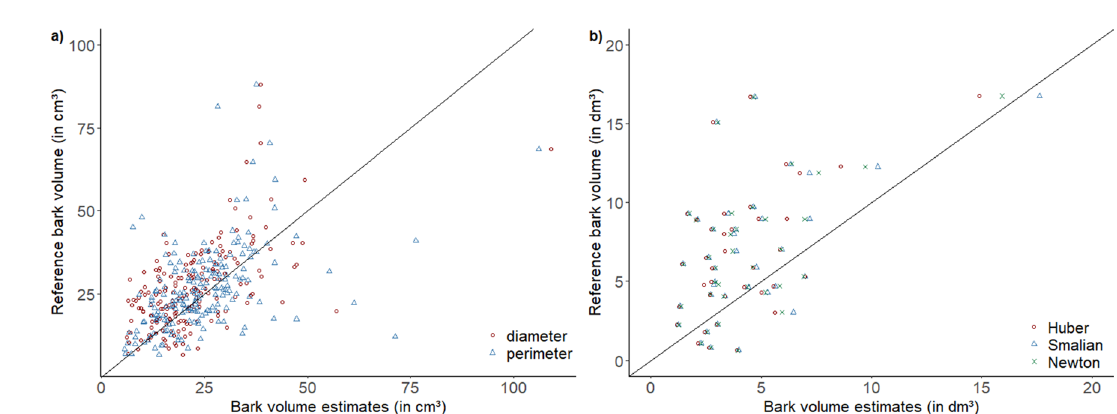
Figure 3. Scatterplots showing the reference bark volume (immersion) against bark volume estimations for ( a ) wood discs using the diameter (Eq. 2) and perimeter (Eq. 3) and for ( b ) logs using the scaling formulas Huber (Eq. 4),Smalian (Eq. 5) and Newton (Eq.